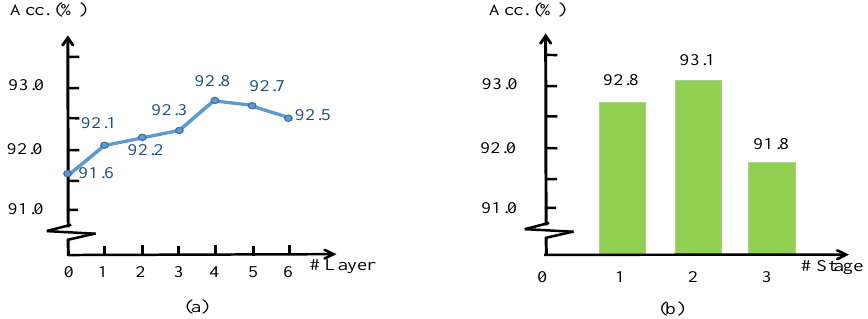
Figure 6. Classification accuracies on ModelNet40 (OA in %) with ( a ) different amounts of PSConv layers in one stage and ( b ) different amounts of stages in PSNet. As shown in the figure, PSNet with 4 layers of PSConv and 2 stages achieves the highest